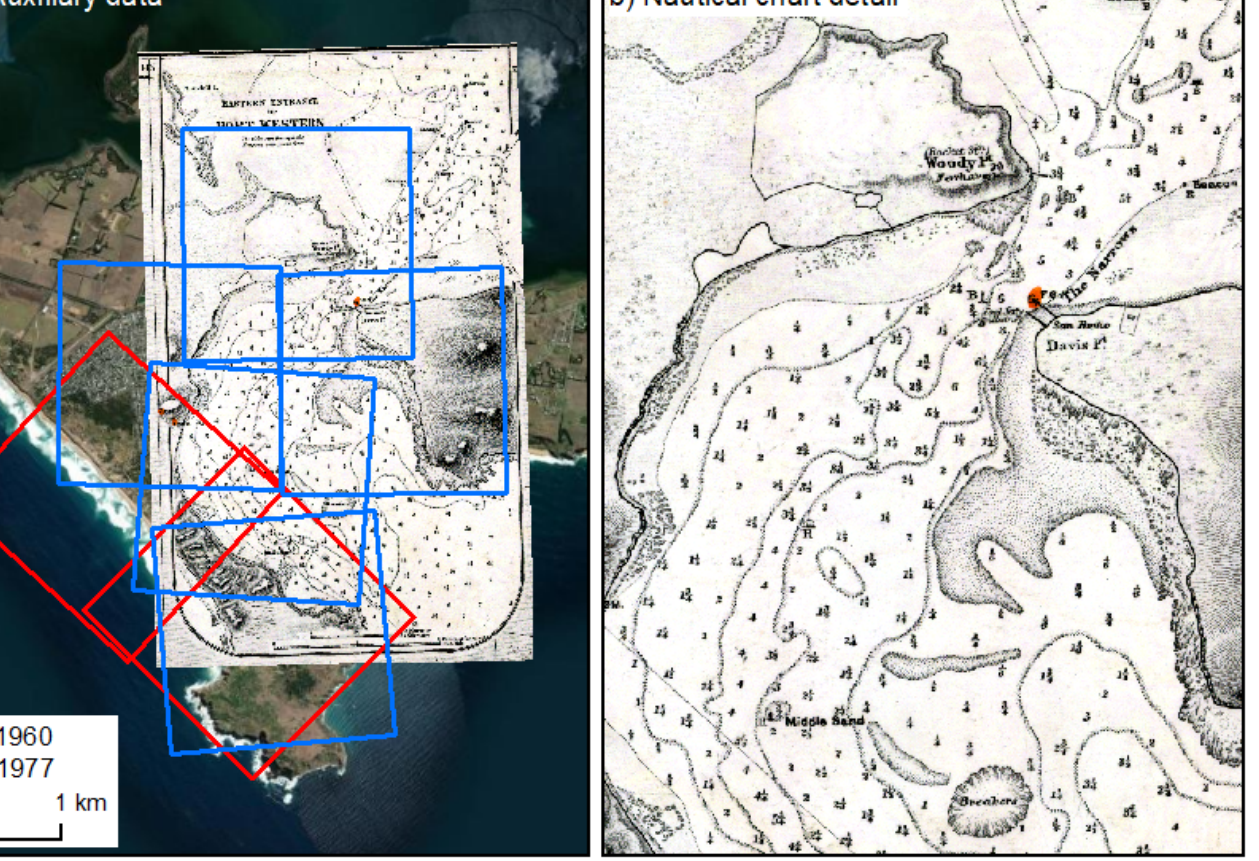
Figure 4. Footprint of the auxiliary georeferenced aerial photographs taken in 1960 and 1977 and nautical chart insert published in 1867 used in the formulation of the sediment budget ( a ). Zoomed-in area showing chart details between San Remo and Newhaven ( b ). Chart publicly available at the State Library Victoria.